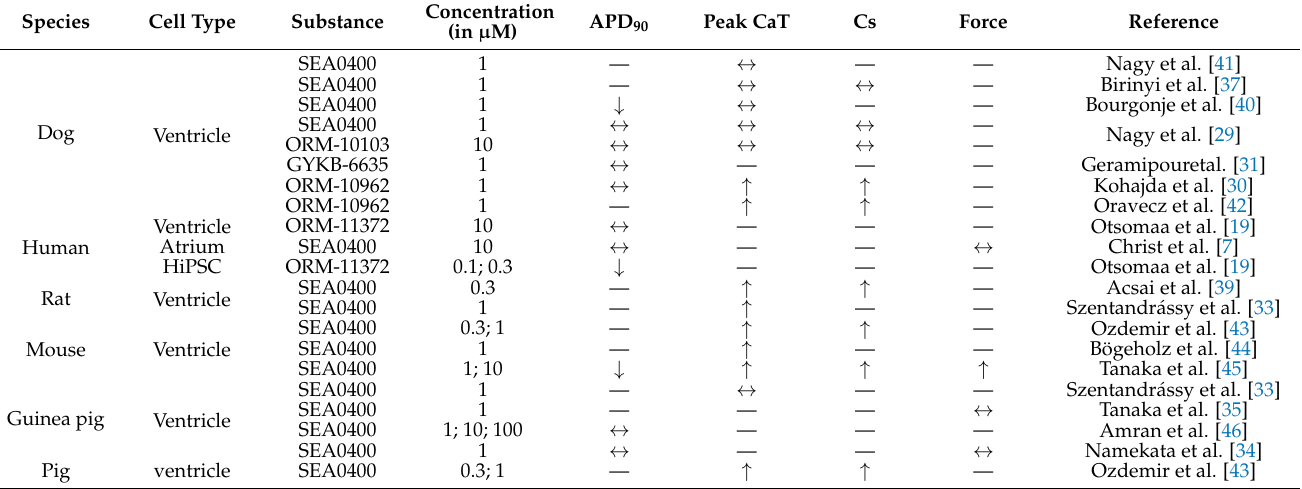
Table 1. Literature research: the effect of NCX block on the APD 90 and contractility parameters in different